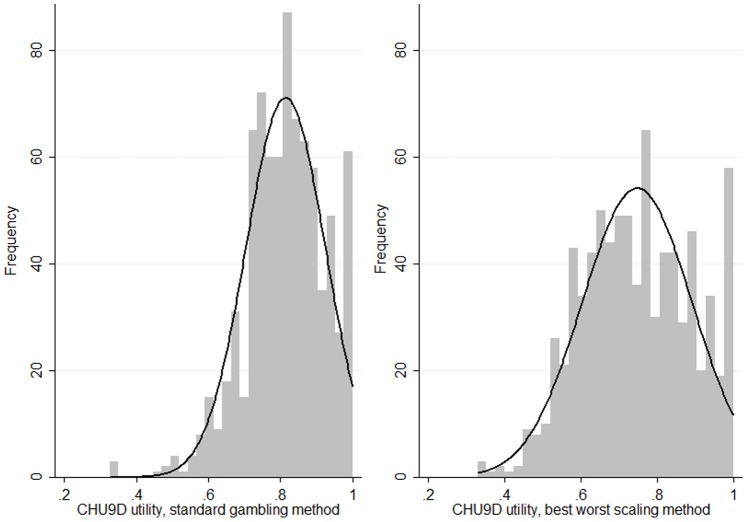
Distributions of Child Health Utility 9D (CHU9D) utilities.